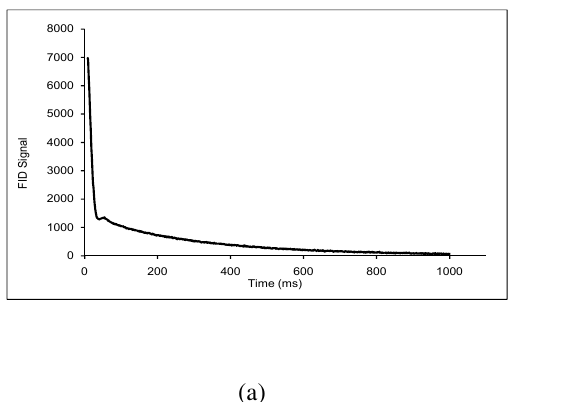
Figure 3. (a) Free-induction decay of lodgepole pine wood chips conditioned at RH = 73%; (b) Typical residuals plot, where the red circles correspond to Equation 2, the orange squares correspond to a combination of gaussian broadened sinc function with an exponential, and the blue triangles correspond to a gaussian function with an